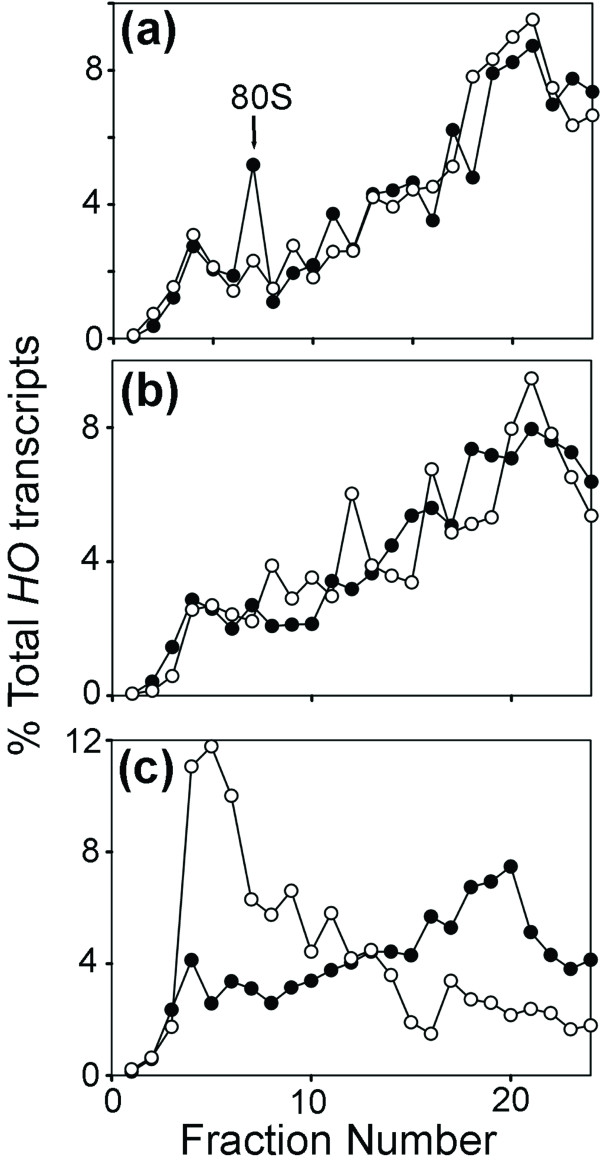
Influence of mutations in the pheromone signaling pathway on translational responses of the HO transcript. The top of the gradient is to the left and the position of the 80S monosome is marked with the arrow. Percentage of total HO mRNA across polysome gradients in growing cells (filled circles) and cells treated with a-factor for 30 minutes (open circles) for strains (a) Δfus3 Δkss1, (b) Δste12, and (c) parental BY2125. Sucrose gradient centrifugation was performed and analyzed as described in Figure 2, using polymerase chain reaction primers that are common to all HO transcripts.